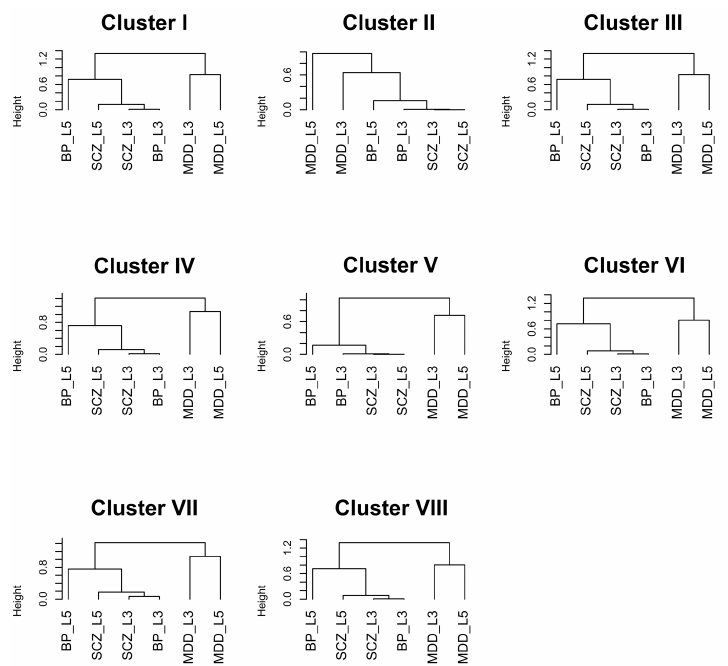
Figure 5. Hierarchical clustering of psychiatric studies in each cluster with distance defined by the log10-scale pathway enrichment p